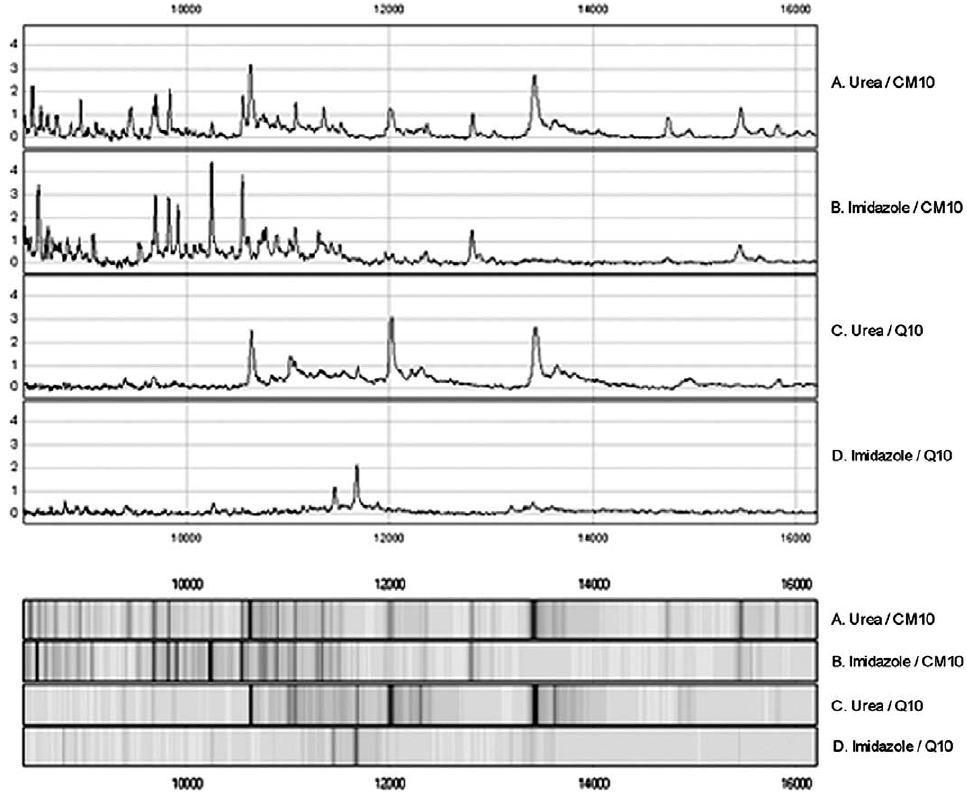
Fig. 1. Comparison of different chip surfaces and lysis buffers for the generation of protein profiles from frozen tissue sections. Frozen tissue sections from a benign reactive lymph node were homogenized in Urea lysis buffer and Imidazole lysis buffer. Equal amounts of protein were loaded onto CM10 and Q10 chips. The upper panel shows a segment of the resulting mass spectra in the range of 9,000–16,000 M/Z ( X -axis). The relative peak intensities are plotted along the Y -axis. The combination of the Urea lysis buffer and CM10 chip surface allows detection of more proteins as compared to the other combinations tested. In the lower panel, the spectra from the upper panel are visualized as gel traces ( gel view